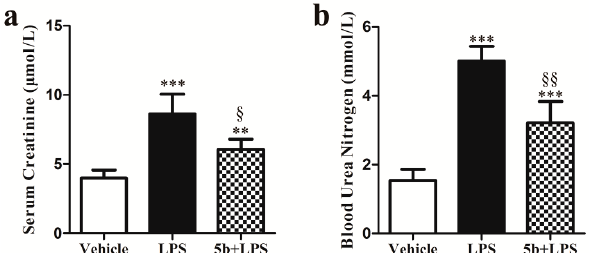
Figure 3. Effect of 5b on SCr ( a ) and blood urea nitrogen (BUN) ( b ) in mice. Data were expressed as means ± SD for groups of six mice. ** p < 0.01 and *** p < 0.001 vs. vehicle group; § p < 0.05 and §§ p < 0.01 vs. LPS group.